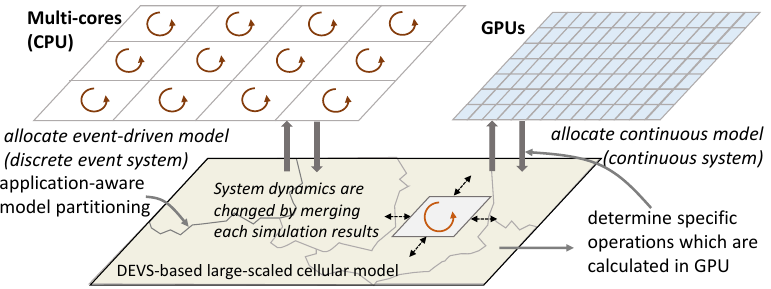
Figure 3. Proposed CPU-GPU tightly coupled computation in DEVS-based